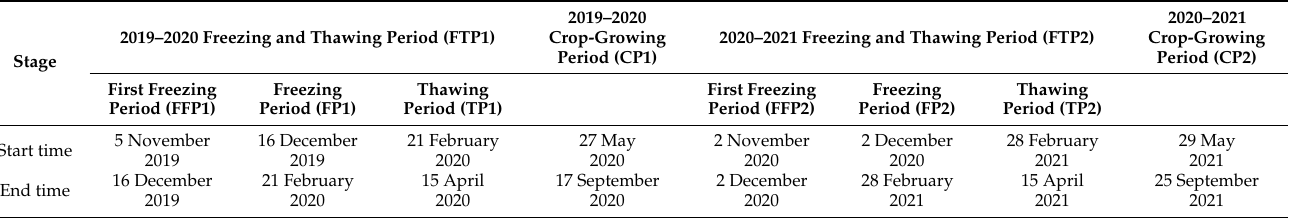
Table 1. The stages of the trial period and their corresponding